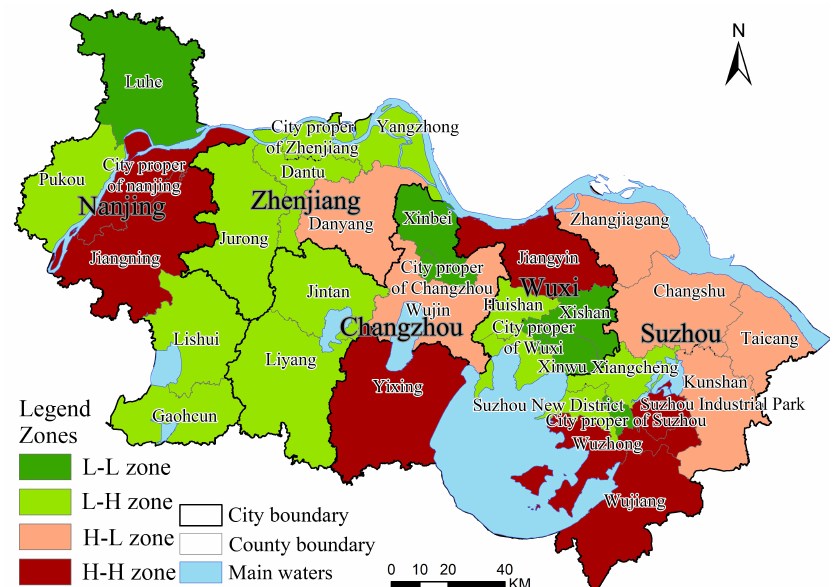
Figure 8. Zones with different construction land expansion extents and their corresponding ecological stress